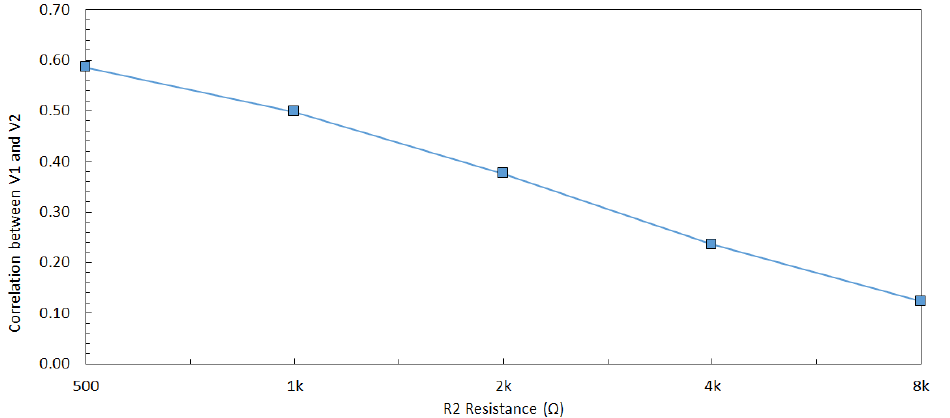
Figure 5. Correlation between V 1 and V 2 with 100,000 traces when R 2 is changed from 500 Ω and 8 k Ω